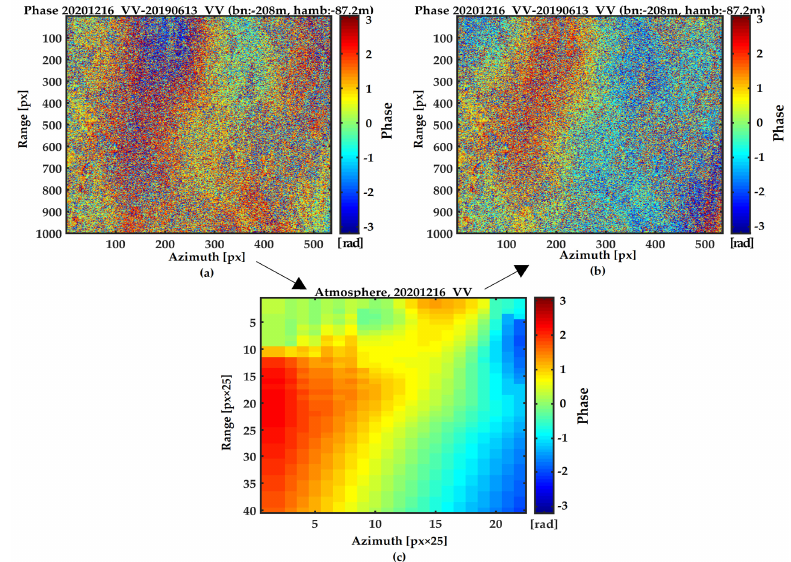
10 of 19 Figure 10. Temporal coherence histogram after atmospheric phase screen removal (example of descending VV data).